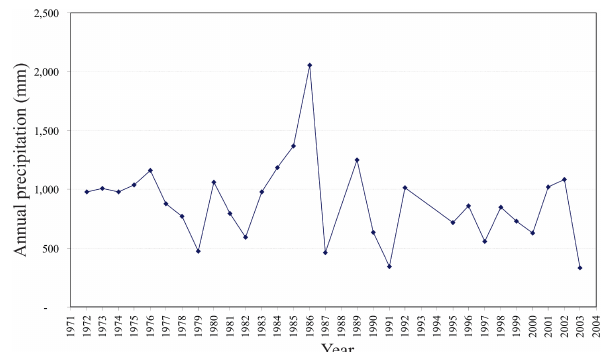
Figure 13. Timeline showing the year 1986 with estreme precipita- tion recorded in the region of MDOT. Data from the 15183-El Oro meteorological station from Corona Chávez et al.